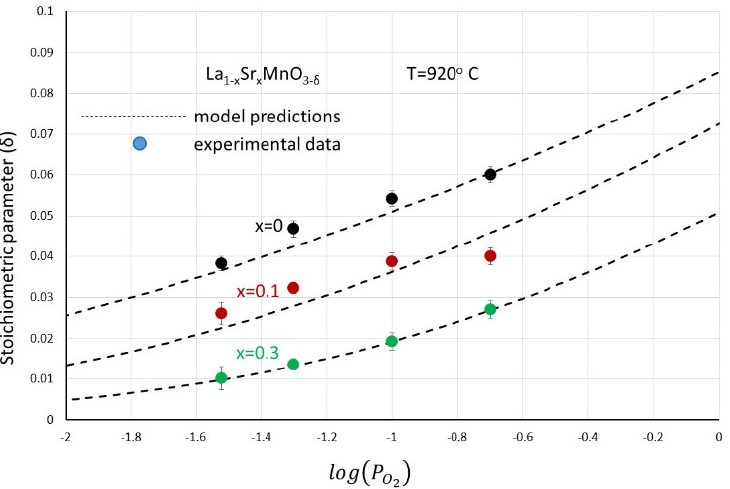
Figure 11. The oxygen excess experimental data of (La 1 − x Sr x )MnO 3 materials (points) in comparison with the predictions of the defect model (dashed lines) expressed by Equations (6) and (7).